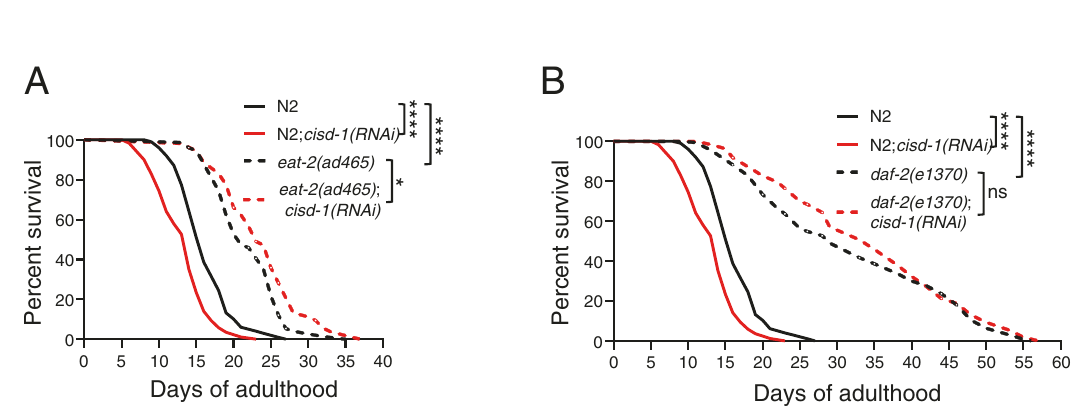
Fig. 5 CED-9 is required for proteostasis perturbation and neurodegeneration upon CISD-1 depletion. A Representative images of head body wall muscles in day-4 RNAi-treated animals of the PD model strain UA49 [p unc-54 α Syn::GFP] treated with empty vector (control), cisd- 1(RNAi) , ced-9(RNAi) , cisd-1/ced-9(RNAi) , unc-51(RNAi) , double RNAi for unc-51 and cisd-1 , double RNAi for unc-51 and ced-9 , double RNAi for unc- 51 and cisd-1/ced-9 (double RNAi construct). B Quanti fi cation of α -Syn::GFP positive puncta in head body wall muscles cells of RNAi-treated UA49 animals. Values represent mean ± SD ( n = 25; ns P > 0.05 , *P < 0.05, ** P < 0.01, **** P < 0.0001, one-way ANOVA/ Tukey ’ s multiple comparisons test). C Representative images of day-1 adult animals of the HD model strain AM141 [p unc-54 Q40::YFP] treated with empty vector (control), cisd-1(RNAi) , ced-9(RNAi) , cisd-1/ced-9(RNAi) , unc-51(RNAi) , double RNAi for unc-51 and cisd-1 , double RNAi for unc-51 and ced-9 , double RNAi for unc-51 and cisd-1/ced-9 (double RNAi construct). D Quanti fi cation of Q40::YFP positive puncta per total animal body in RNAi treated AM141 animals. Values represent mean ± SD ( n = 35; ns P > 0.05, ** P < 0.01, ***P < 0.001, **** P < 0.0001, one-way ANOVA/ Tukey ’ s multiple comparisons test). Scale bars, 20 μ m. E Mechanosensory neurons were observed by using day-4 adult animals of the SK4005 [p mec-4 GFP] reporter strain treated with empty vector (control), cisd-1(RNAi) , ced-9(RNAi) , cisd-1/ced-9(RNAi) , unc-51(RNAi), double RNAi for unc-51 and cisd-1 , double RNAi for unc-51 and ced-9 , double RNAi for unc-51 and cisd-1/ced-9 (double RNAi construct). The neurons were classi fi ed into three categories depending on the axonal morphology (normal, intermediate and severe phenotype). The graph represents the percentage of neurons for each category and the statistical differences shown are relative to control RNAi-treated animals. Values represent mean ± SEM from three independent experiments ( n = 40; ns P > 0.05, * P < 0.05, ** P < 0.01, *** P < 0.001, **** P < 0.0001, one-way ANOVA/ Tukey ’ s multiple comparisons test). Scale bars in all panels are 20 μ m. F Dopaminergic neurons were observed by using day-3 adult animals of the UA196 [ sid- 1(pk3321) ; baIn33 (p dat-1 SID-1, p myo-2 mCherry); (p dat-1 α -Syn, p dat-1 GFP)] reporter strain treated with empty vector (control), cisd-1(RNAi) , ced- 9(RNAi) , cisd-1/ced-9(RNAi) , unc-51(RNAi) , double RNAi for unc-51 and cisd-1 , double RNAi for unc-51 and ced-9 , double RNAi for unc-51 and cisd-1/ ced-9 (double RNAi construct). The graph represents the percentage of intact neurons. Values represent mean ± SEM from three independent experiments ( n = 20; ns P > 0.05, *** P < 0.001 **** P < 0.0001, one-way ANOVA/ Tukey ’ s multiple comparisons test).